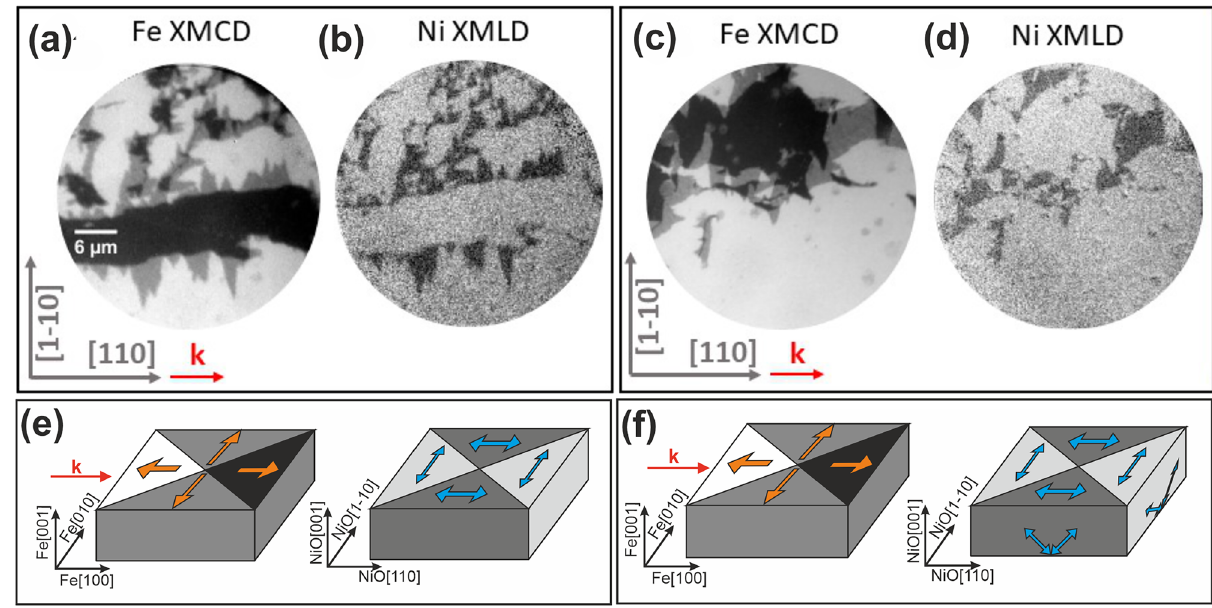
Figure 4. ( a , c ) The Fe L 3 XMCD-PEEM images obtained for Fe/NiO/MgO(10 Å)/Cr and Fe/NiO/ MgO(200 Å)/Cr, respectively. ( b ) and ( d ) corresponding Ni L 2 XMLD-PEEM images acquired with vertical polarization. ( e ) and ( f ) a schematical illustration of spin structure with directions of magnetic moments indicated by the arrows for Fe/NiO/MgO(10 Å)/Cr and Fe/NiO/MgO(200 Å)/Cr,